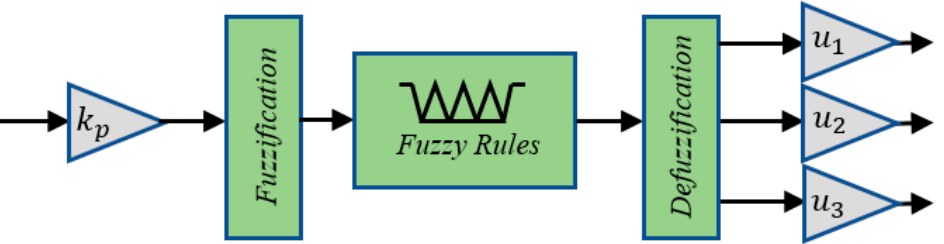
Figure 9. Structure of fuzzy logic.